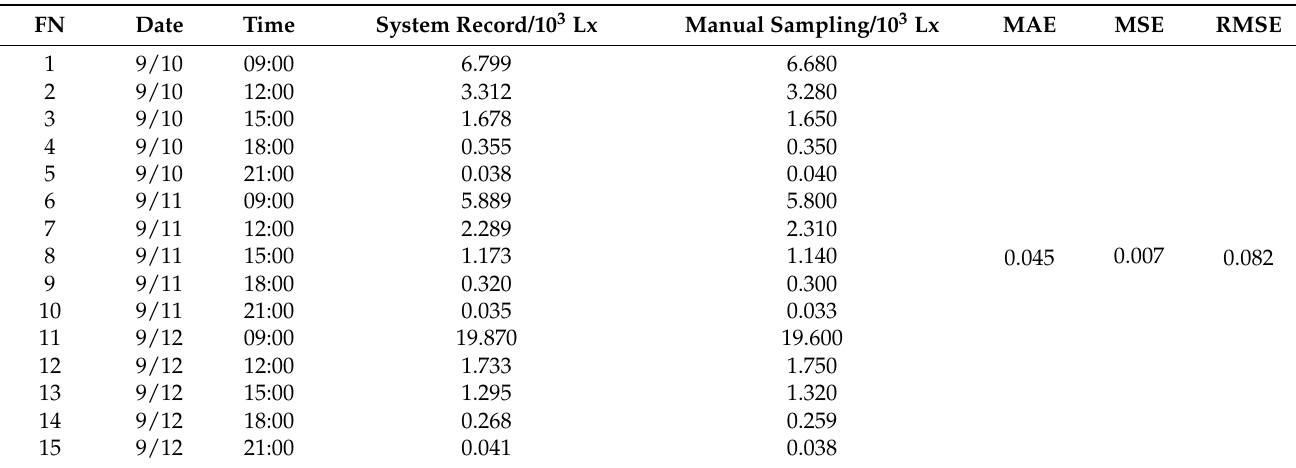
Table 5. Comparison of the results of light intensity value.